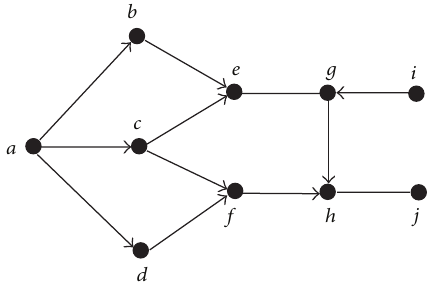
Figure 1: A chain graph G 𝑉